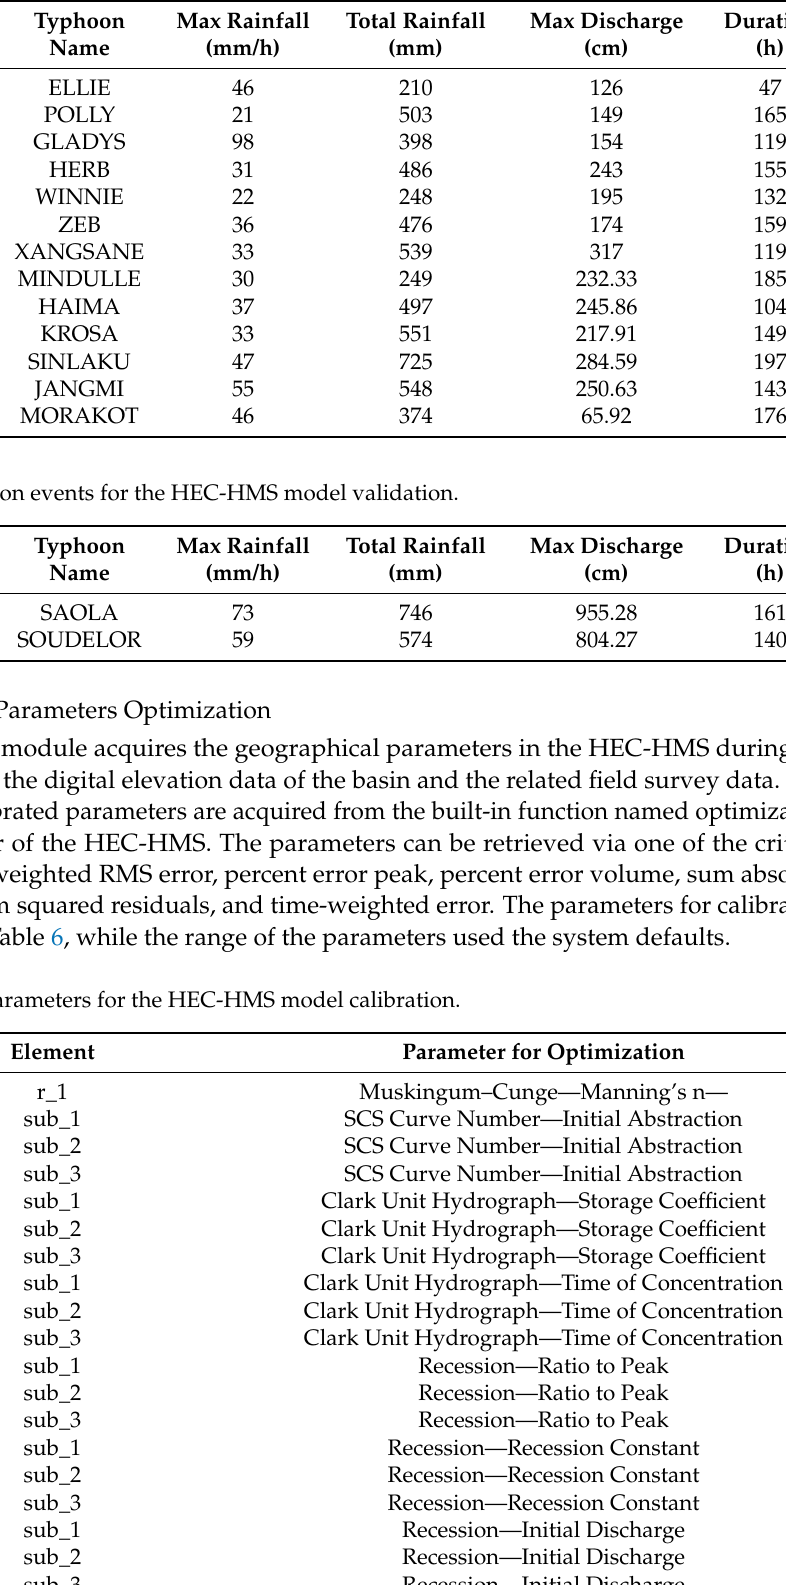
Table 4. Typhoon events manipulated for the HEC-HMS parameter calibration.